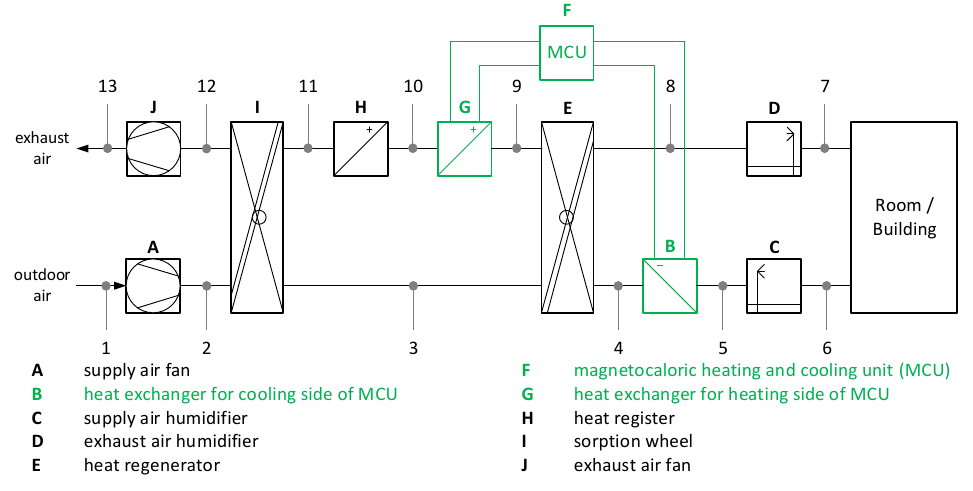
Figure 1. Main parts of a standard (black) and an extended (green) Desiccant Evaporative Cooling (DEC)